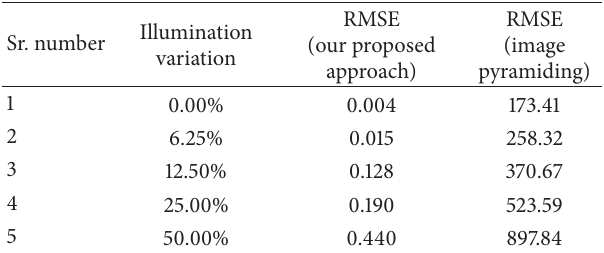
Table 2: RMSE for various illumination variations (input stereo pair: tsukuba).